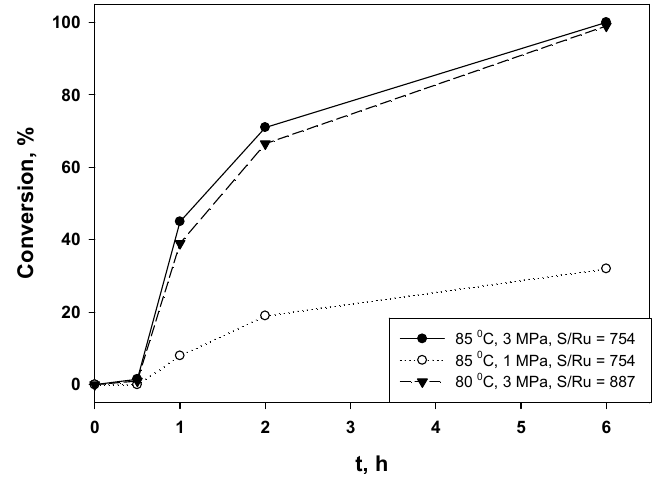
Figure 6. Kinetics of phenol hydrogenation in water in the presence of G3-dendr-SiO 2 -Ru at substrate/Ru = 754–887. Reaction conditions are: m (PhOH) = V (H 2 O).